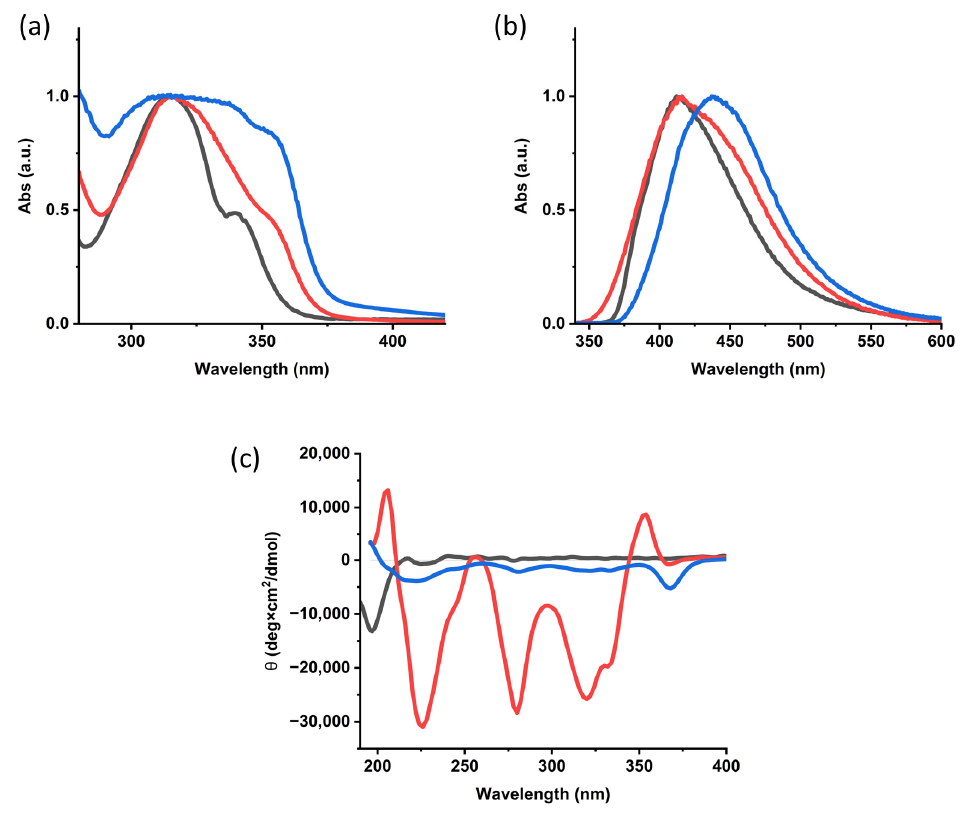
Figure 3. Normalized ( a ) UV-Vis absorption and ( b ) emission spectra and ( c ) CD spectra of 1 in aqueous solution at 10 − 5 M (black line), at 5.6 × 10 − 3 M (red line) and the gelled sample (blue line).